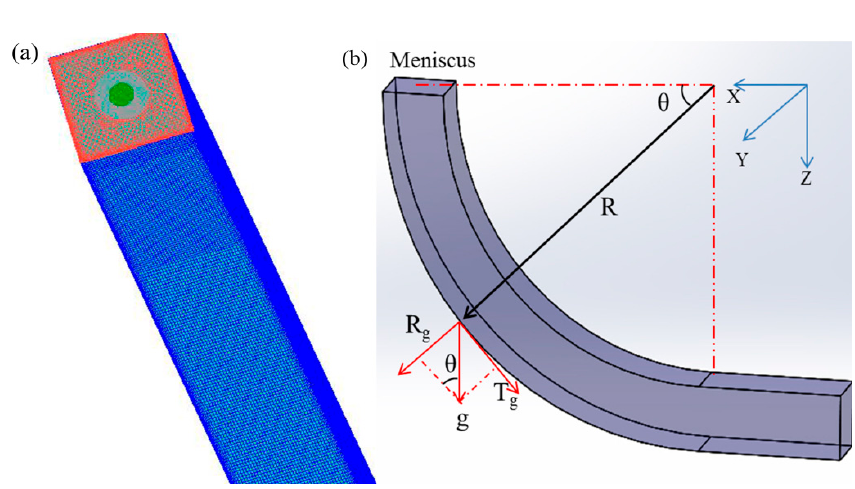
Figure 1. Vertical mesh adopted here ( a ); and reconstruction of gravitational acceleration ( b ).